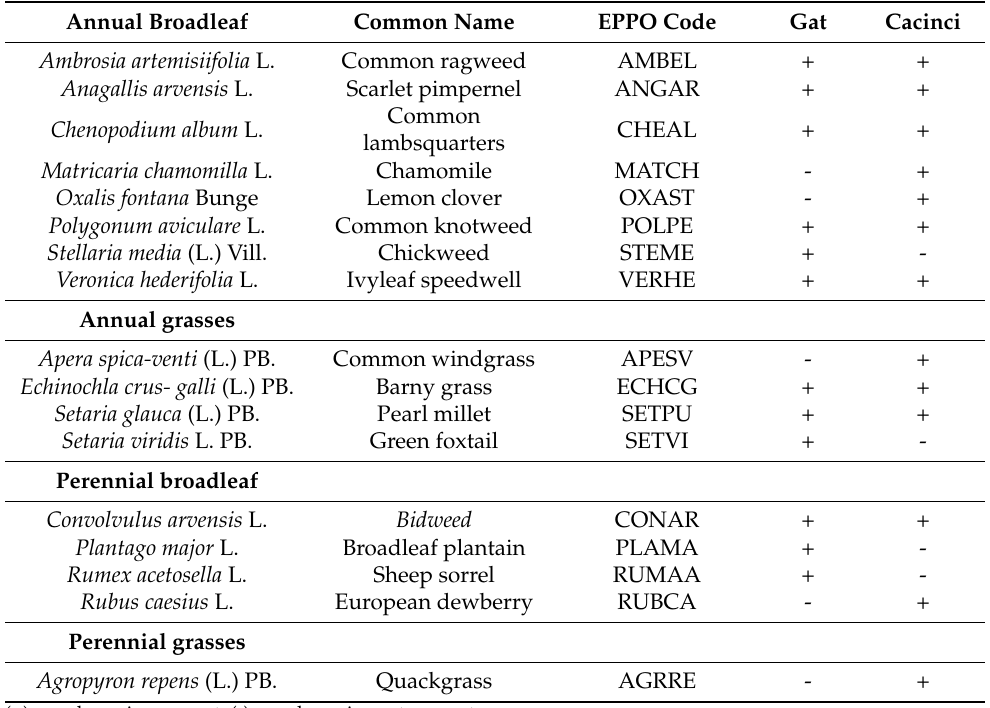
Table 4. Weed species composition at experimental sites Gat and Cacinci. Annual